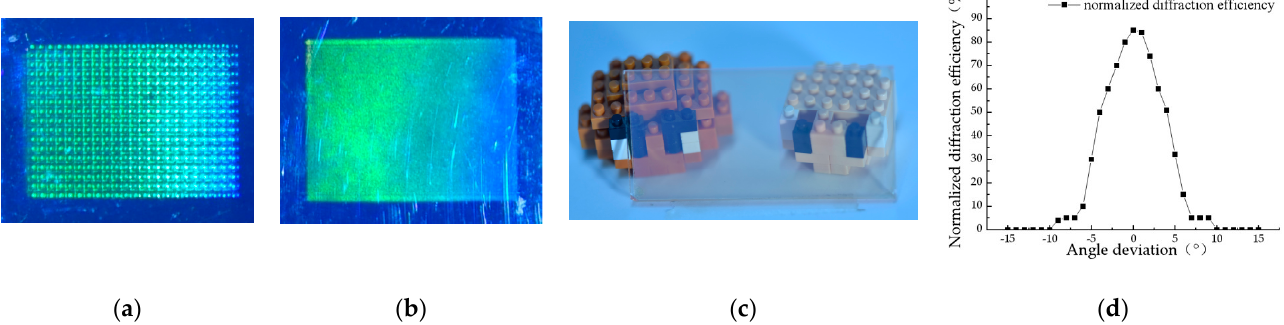
Figure 6. Performance testing of MHOE: ( a ) Diffraction effect of the MLA; ( b ) diffraction effect of the diffuser; ( c ) optical see-through properties of MHOE; ( d ) relationship between normalized diffraction efficiency and angle deviation.